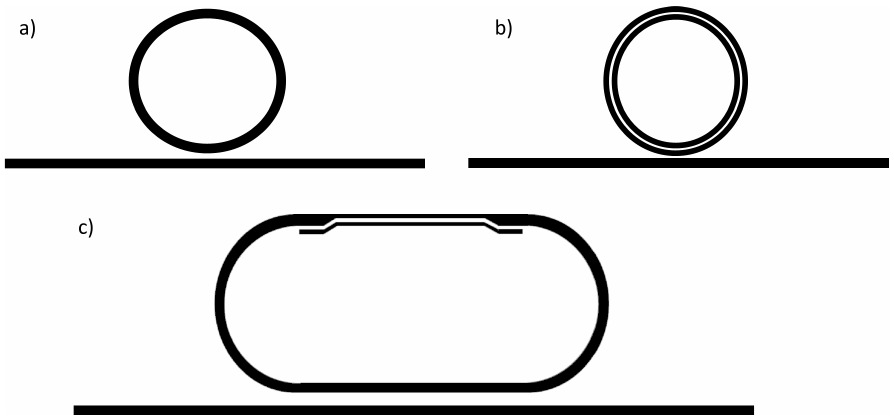
Figure 4. Schematics of different ring resonator concepts: ( a ) Common silicon strip-waveguide ring resonator.